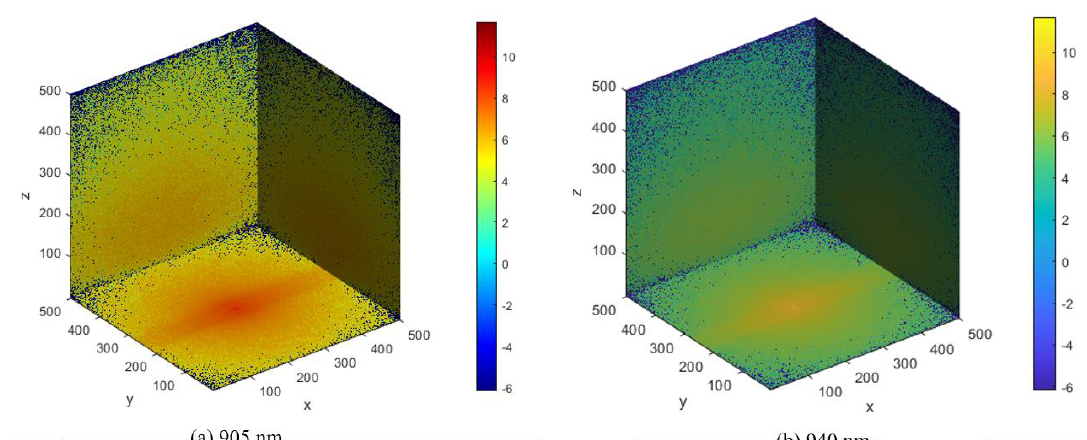
Figure 9. Photon fluence in the voxel-based finger model 3D view.